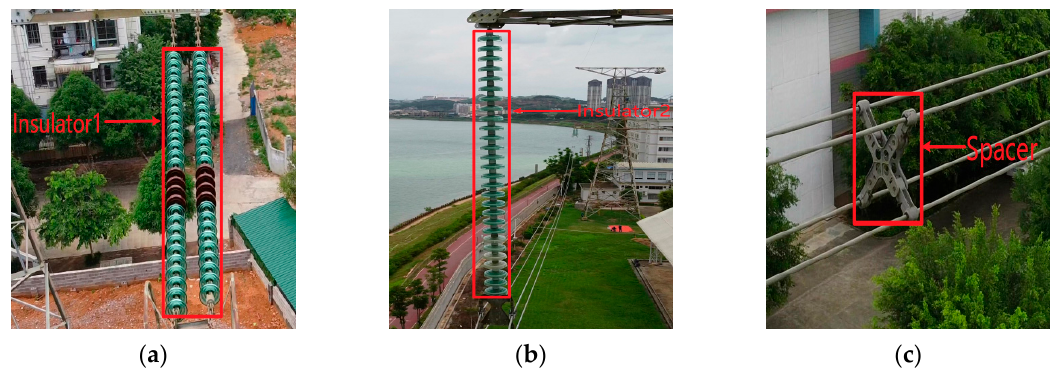
Figure 1. Electrical components: ( a ) Insulator1; ( b ) Insulator2; ( c ) Spacer.